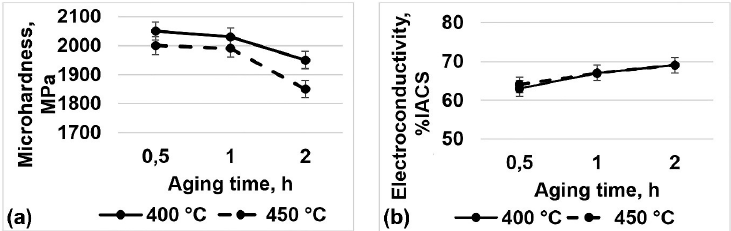
Figure 7: Change in microhardness and electrical conductivity depending on the time and temperature of aging: a—microhardness; b— electrical conductivity.